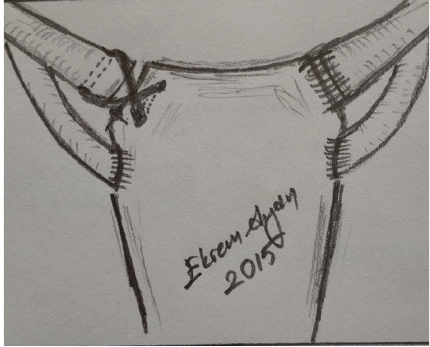
Figure 4: Schematic.